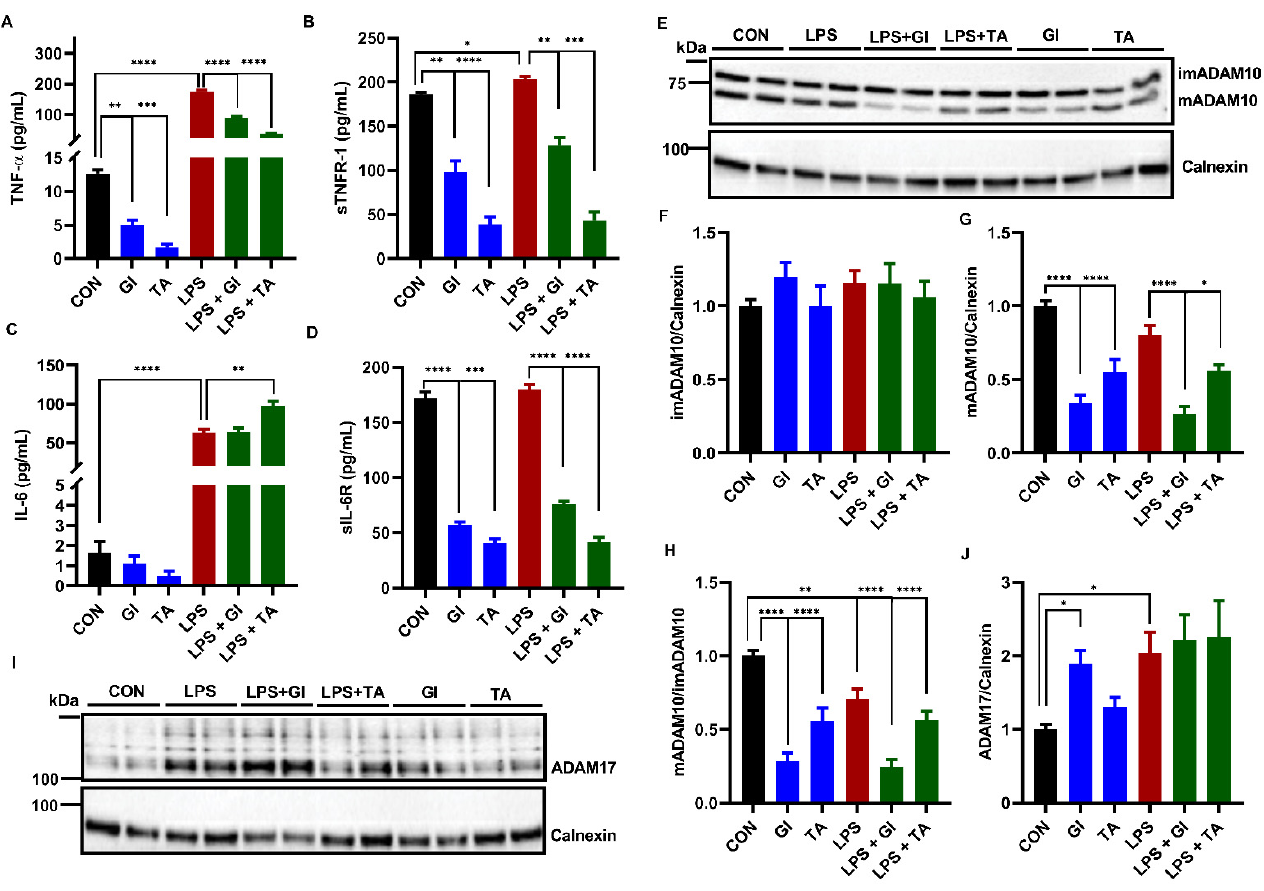
Figure 2. The effect of ADAM10 inhibitor (GI254023X) or ADAM17 inhibitor (TAPI-1) on the release of TNF- α , TNFR-1 and IL-6R by constitutively and under inflammation BV2 microglia. BV2 microglia were incubated with GI254023X (5 µ M) or TAPI-1 (25 µ M) for 24 h in the absence or presence of 1000 ng/mL LPS. The medium was collected for ELISA measurements and cell lysates were lysed for WB analysis. The concentration of TNF- α ( A ), sTNFR-1 ( B ), IL-6 ( C ) and sIL-6R ( D ) released in medium ( n = 6 from 6 independent experiments). ( E ) The representative immunoblots of ADAM10 protein expression in BV2 cell lysate. ( F – H ) The quantification of ADAM10 expression in BV2 cell lysate ( n = 10 from 5 independent experiments). ( I ) The representative immunoblots of ADAM17 expression in BV2 cell lysate. ( J ) The quantification results of ADAM17 in BV2 cell lysate ( n = 8 from 4 independent experiments). Calnexin was used as a loading control. Black: constitutive cytokine release or protein expression set at 1; red: LPS-induced cytokine release or protein expression; blue: effect of ADAMs inhibitor on constitutive cytokine release or protein expression; green: effect of ADAMs inhibitor on LPS-induced cytokine release or protein expression. Results were expressed as mean ± SEM. * p < 0.05, ** p < 0.01 *** p < 0.001 , **** p <